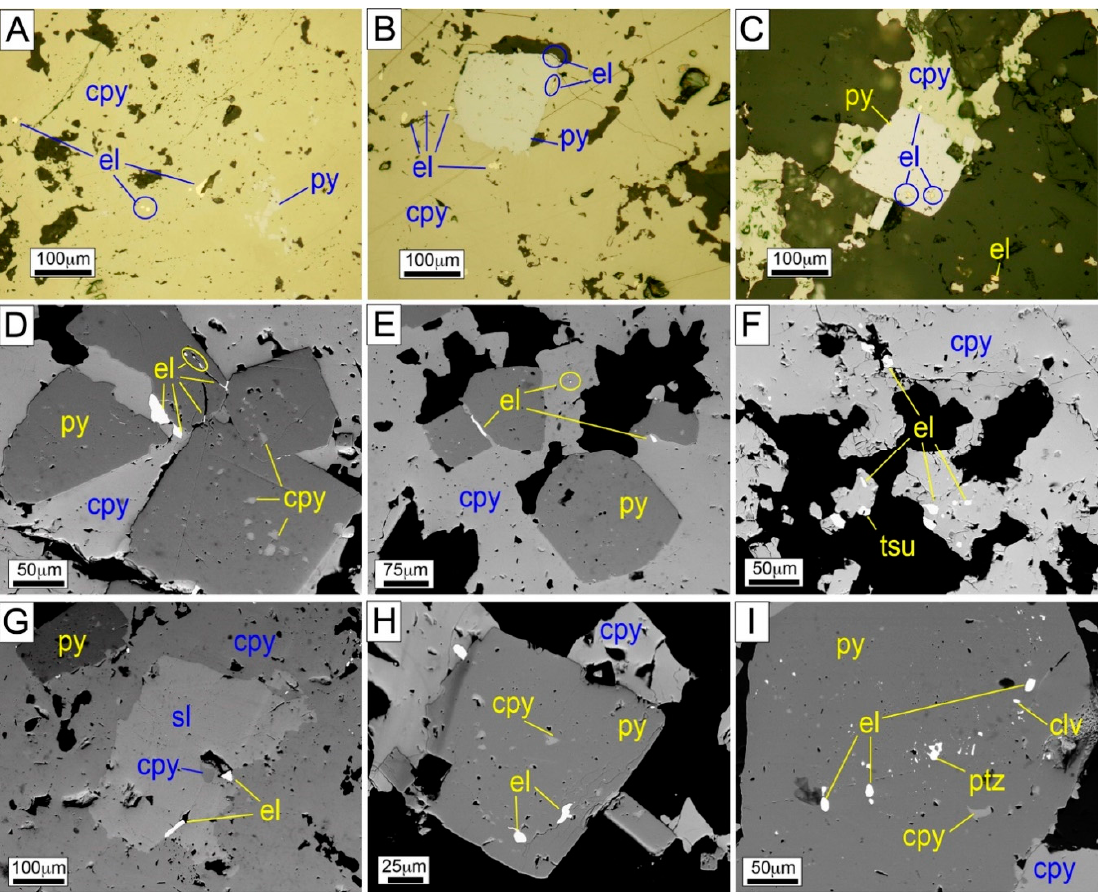
Figure 9. Thin section photomicrographs (reflected light: A – C ) and SEM images (EDS mode: D – I ) of electrum particles found in the Romero deposit lining vuggs in chalcopyrite ( A , B , D – F ), pyrite ( C , D , H , I ), and sphalerite ( G ) and in the gangue matrix ( C ). Abbreviations: clv = calaverite; cpy = chalcopyrite; el = electrum; sl = sphalerite; ptz = petzite; py = pyrite; tsu = tsumoite.